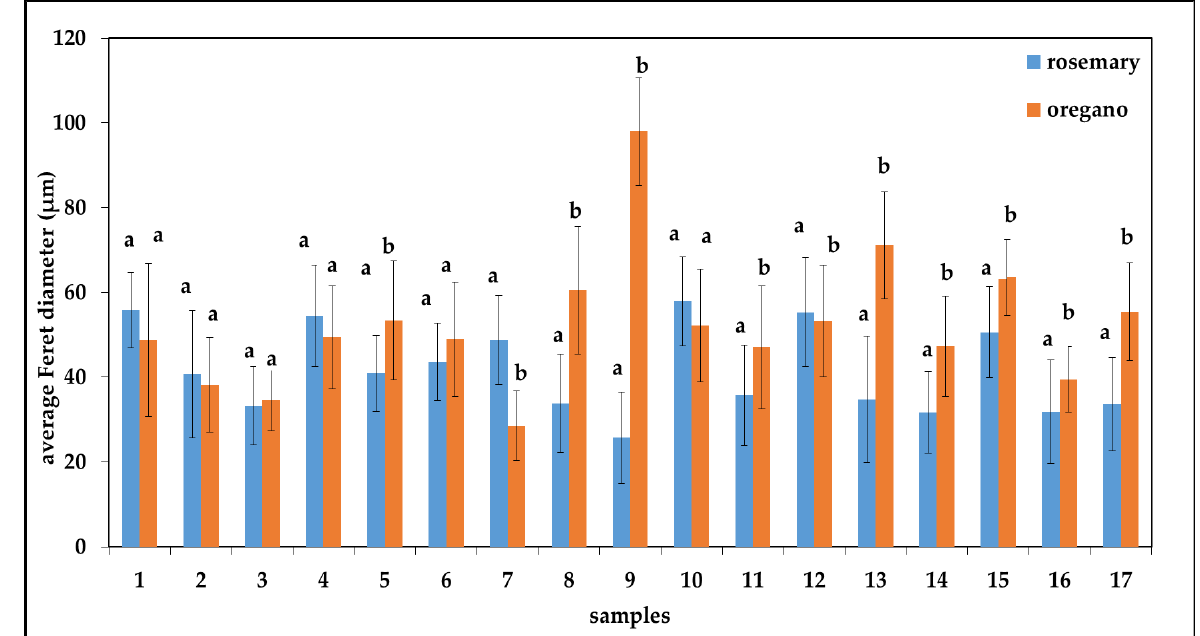
Figure 2. Average Feret diameters of oil-in-water emulsions containing rosemary extract and oil-in- water emulsions containing oregano extract. Different letters above the columns represent significant differences at p < 0.05. Table 1. Physical properties of oil-in-water emulsions containing rosemary/oregano extract with the addition of commercial pea protein as emulsifier. A,B The same superscript capital letters within a row denote no significant differences ( p > 0.05) between the values obtained for the different emulsions under the same experimental conditions according to Tukey’s ANOVA. a–j The same superscript lowercase letters within a column denote no significant differences ( p > 0.05) between the values obtained for the emulsions under the different experimental conditions according to Tukey’s